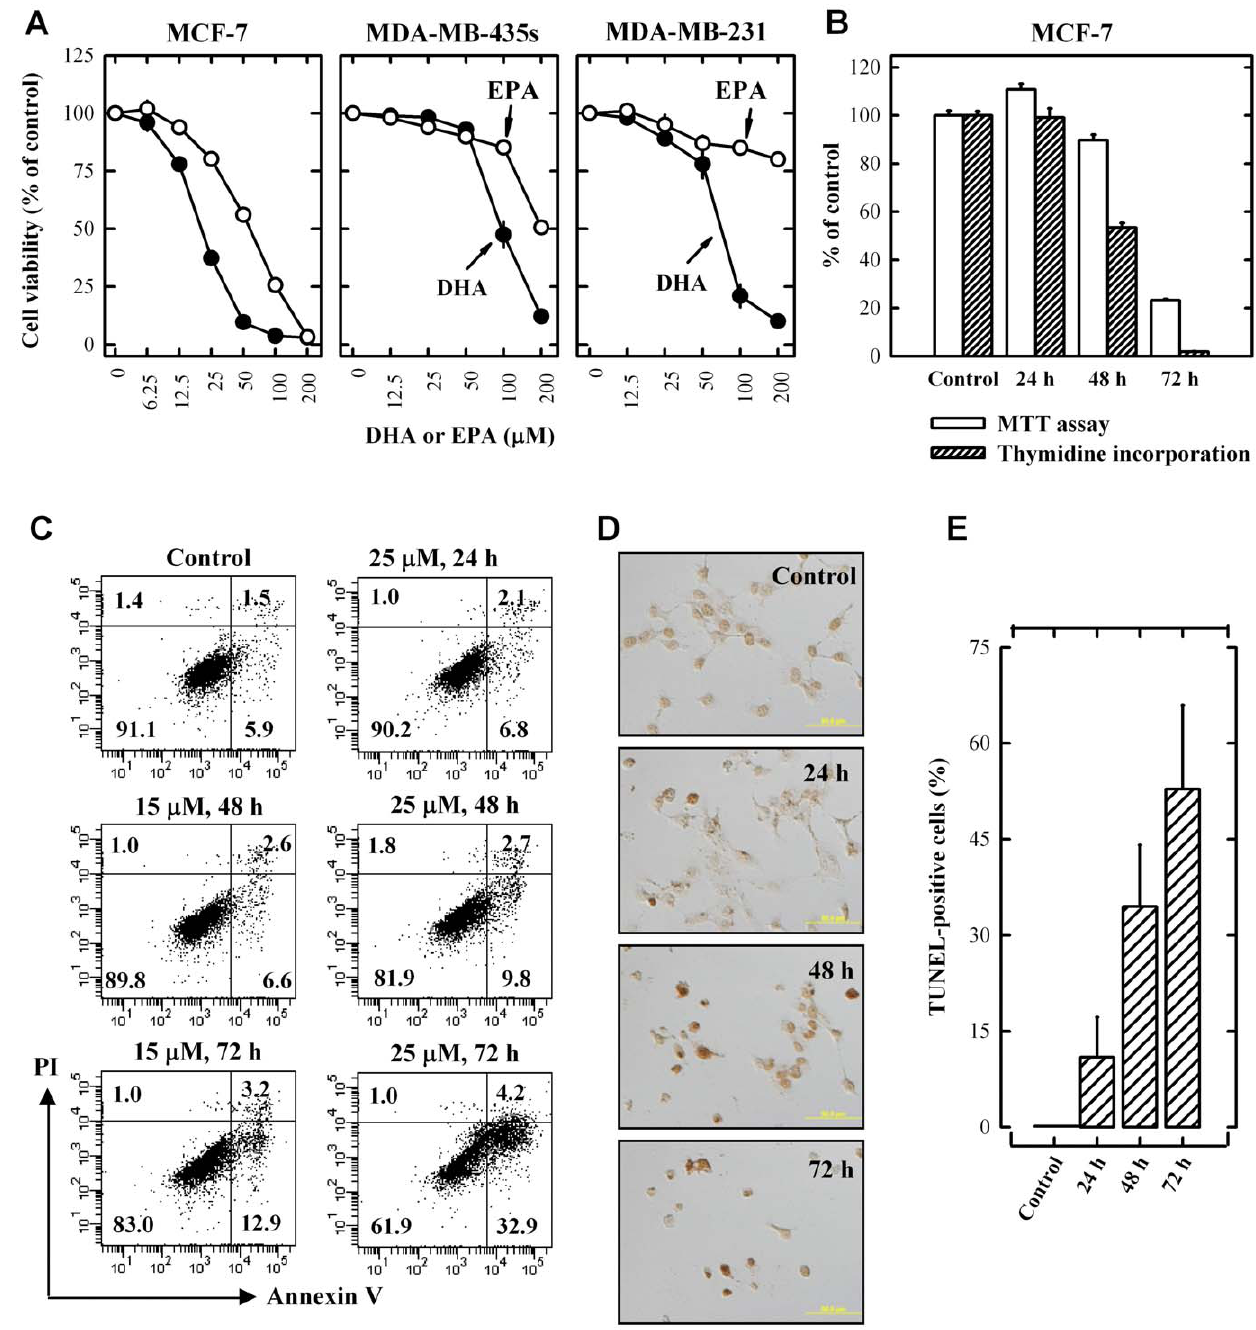
Figure 1. DHA and EPA inhibit MCF-7 cell growth in a concentration-dependent manner. ( A ) Cell viability (MTT assay) of MCF-7 cells, MDA-MB-231 and MDA-MB-435s cells treated with DHA or EPA at indicated concentrations for 72 h. Each value is the mean 6 S.E. (n=6). Note that for some of the data points, the error bars are smaller than the diameter of the symbols. ( B ) MTT and thymidine incorporation assays for MCF-7 cells treated with 25 m M DHA for the indicated length of time. Each value is the mean 6 S.E. (n=6 for both assays). ( C ) Annexin V/PI staining of MCF-7 cells treated with 15 m M and 25 m M DHA for the indicated length of time. The percentage of cells in each of the four quadrants was shown inside of each area. ( D ) TUNEL staining of MCF-7 cells treated with 25 m M DHA for the indicated length of time. The dark brown cells were positively-stained cells. ( E ) Quantification of TUNEL-positive cells as percentage of total cells. Each value is the mean 6 S.D. (n=3).